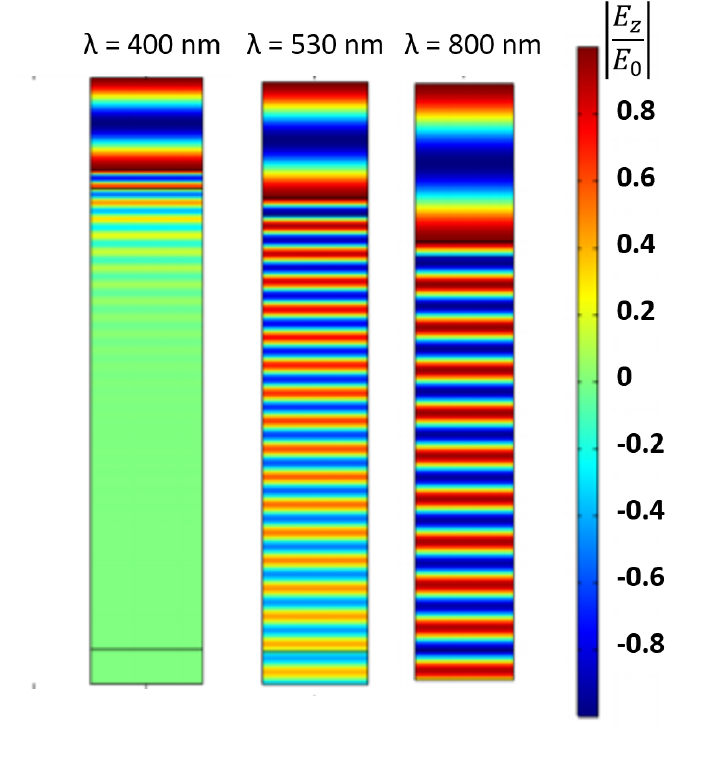
Figure 13. Normalized Electric field, z-component of the cross section of a PIN